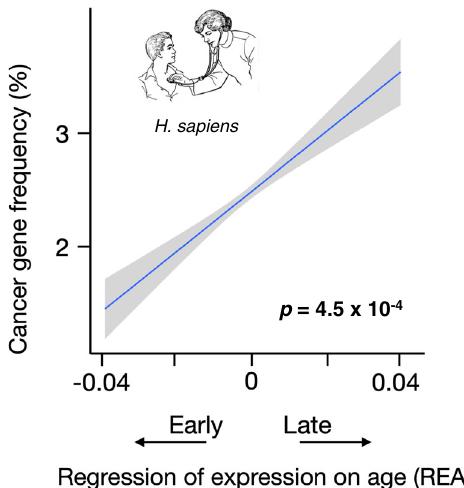
Fig. 4 Late genes are more likely to be driver genes for adult cancers in humans. The probability that a gene is associated with adult cancers is signi fi cantly correlated with its age of expression in humans. Signi fi cance was determined by a Spearman rank correlation (two-sided test). The line is the least squares regression, and the gray region shows the approximate 95% con fi dence interval for the regression. See also Supplementary Fig. 4.